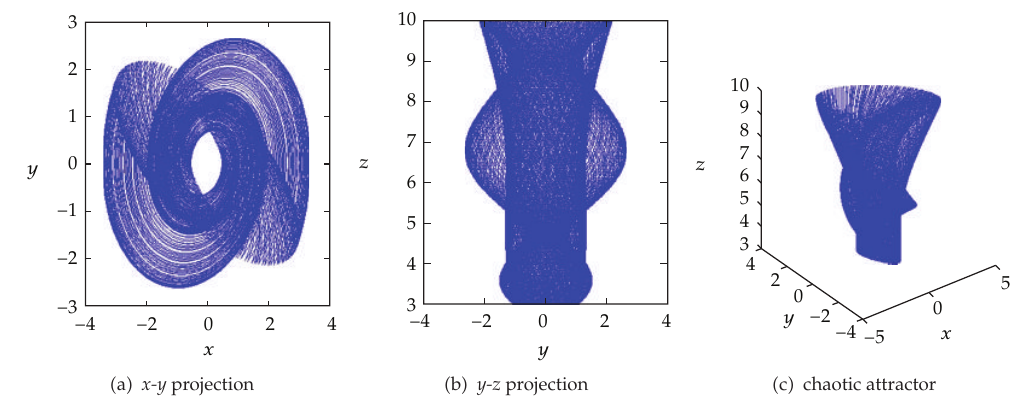
Figure 5: Chaotic attractor generated by z 1 (cid:7) 3, z 2 (cid:7) 10.